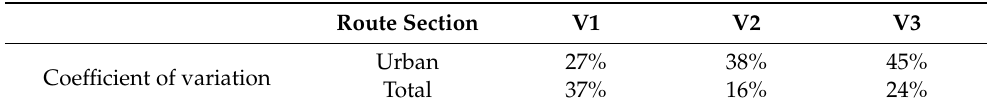
Table 3. Coefficient of variation of SPN 23 emissions under the on-road tests with four different REESS states of charge, i.e., 100%, 50%, 25%, and discharged REESS. Route Section V1 V2 V3 Urban 27% 38% 45% Coefficient of variation Total 37% 16% 24%